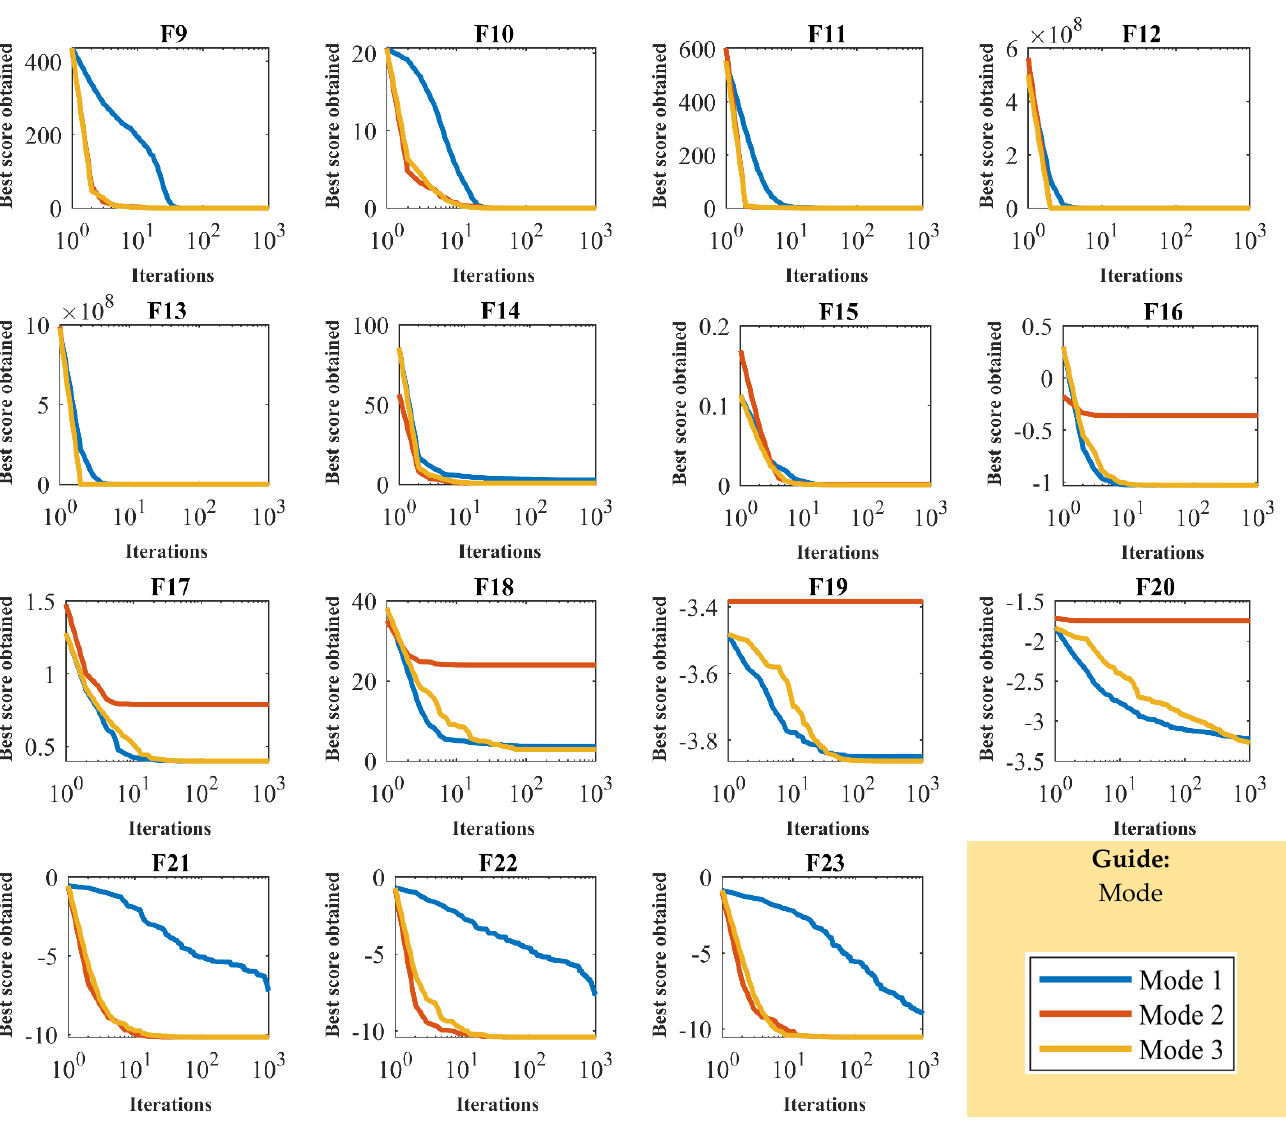
Figure 6. Sensitivity analysis of the SSVUBA to effectiveness of each case in Equation (4).